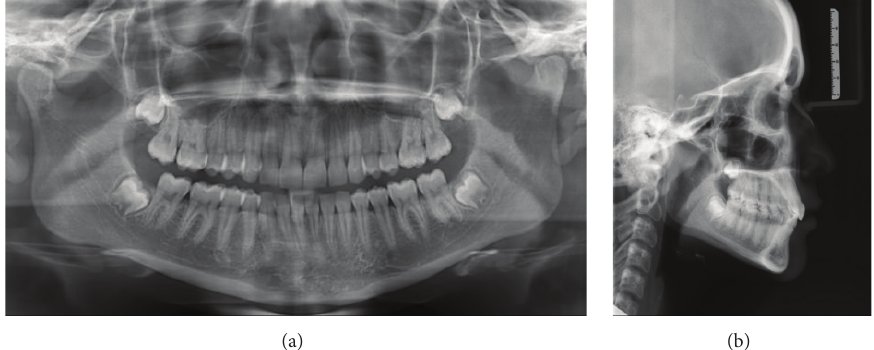
Figure 8: Final radiographs. In panoramic radiography, good positioning of all erupted teeth and parallelism of roots are observed (a); in teleradiography it is noted good maxillomandibular relationship as well as between the upper and lower incisors